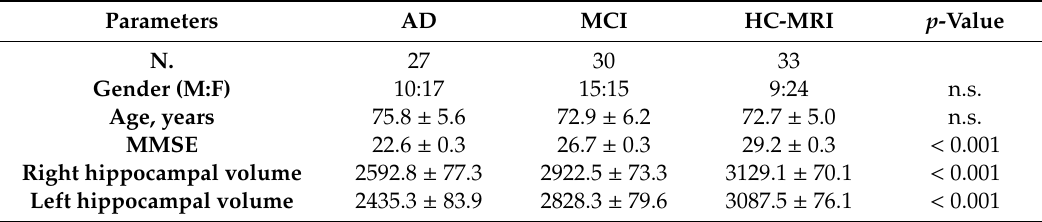
Table 2. Demographical data and hippocampal volume in the selected subgroup of AD and MCI subjects with serum presence of IgG 3 , in comparison with a template of healthy subjects